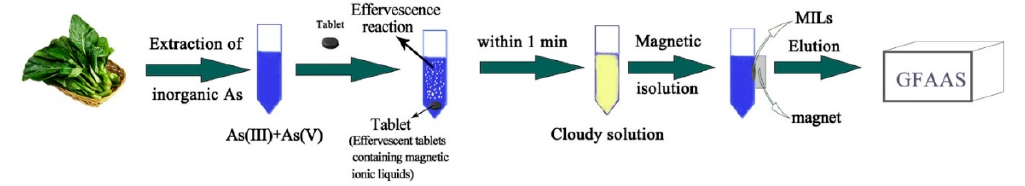
Figure 2. The scheme of the proposed ETA ‐ MILs ‐ ME. Reproduced with permission from [40]. Cop ‐ yright Elsevier,